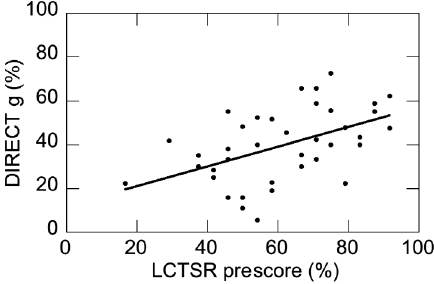
FIG. 4. Normalized learning gains on DIRECT versus LCTSR prescore. The solid line is the line of best fit (slope ¼ 0 : 45 and r ¼ 0 : 50 ).